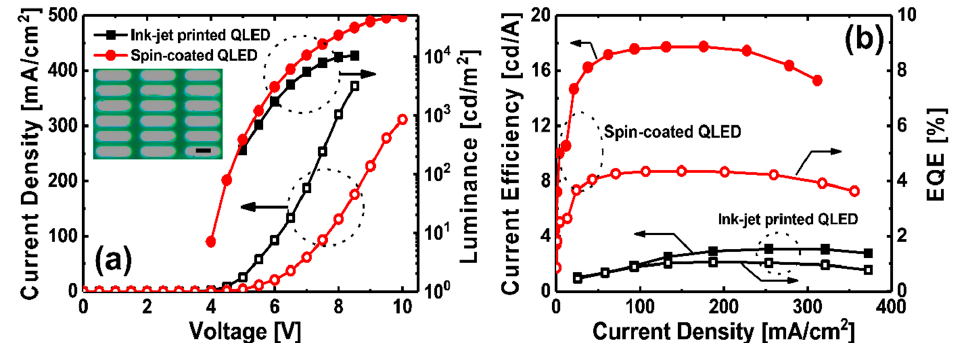
Figure 5. ( a ) Comparison of current density and luminance-voltage characteristics of spin-coated QLEDs and ink-jet printed QLEDs. (Inset: EL images of ink-jet printed QLEDs under applied voltage of 5 V. Scale bar: 100 μ m) ( b ) Comparison of current efficiency and EQE-current density characteristics of spin-coated QLEDs and ink-jet printed QLEDs.